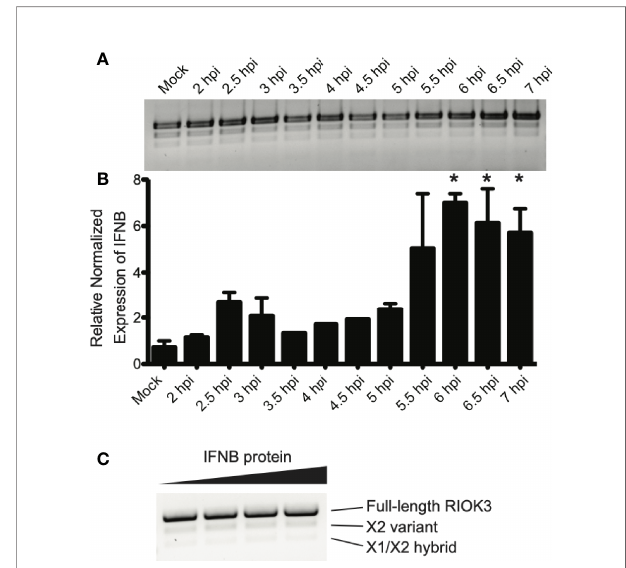
FIGURE 2 | RIOK3 splicing occurs after IFNB activation, and is not affected by IFNB protein. (A) RIOK3 alternative splicing over the fi rst 7 hours of RVFV MP-12 infection in HEK293 cells at MOI = 1, as measured by RT-PCR. (B) IFNB expression measured by qPCR at each timepoint corresponding to RIOK3 alternative splicing in response to RVFV MP-12 infection in the same HEK293 cells as in (A) . Asterisks indicate p < 0.05 compared to mock- infected cells (one-way ANOVA followed by Tukey ’ s HSD). (C) HEK293 cells in a 24-well plate were treated with 0, 0.125, 0.25, or 0.5 m g/ml of IFNB protein for 24h, and RNA was extracted. RT-PCR was performed to amplify RIOK3